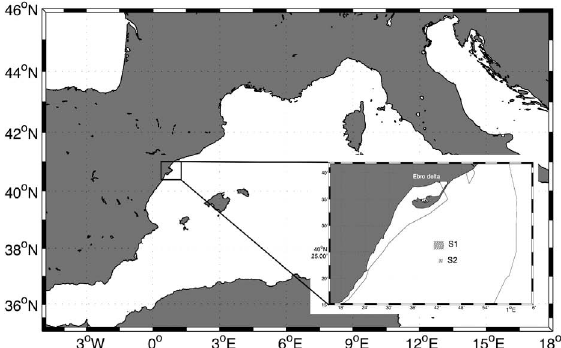
Fig . 1. – Study area located by the Ebro Delta in the northwestern Mediterranean. Detailed map including sites S1 and S2 and the 30